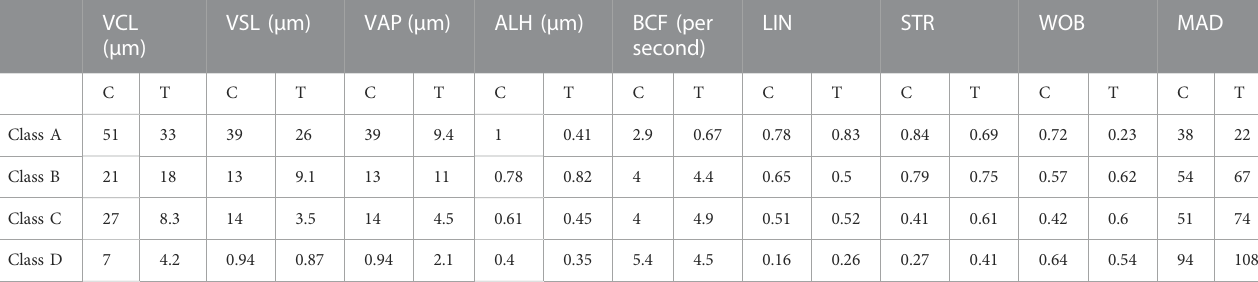
TABLE 1 Variation in sperm motility parameters in the presence and absence of AMLE diluted in